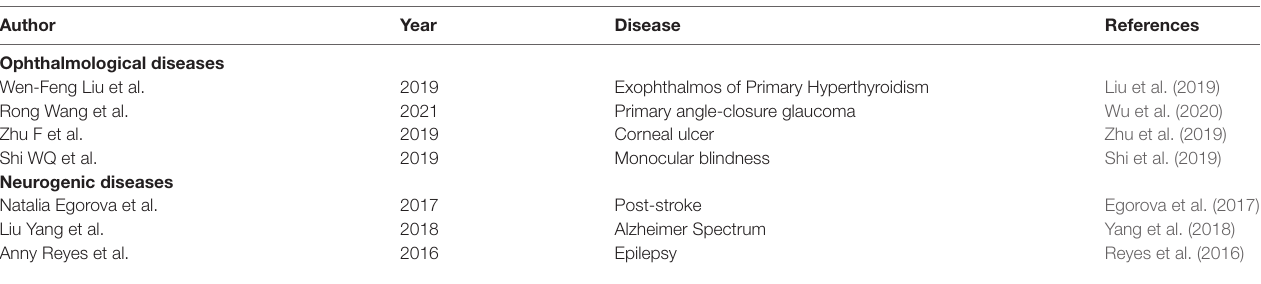
TABLE 4 | Application of fALFF in ophthalmology and other